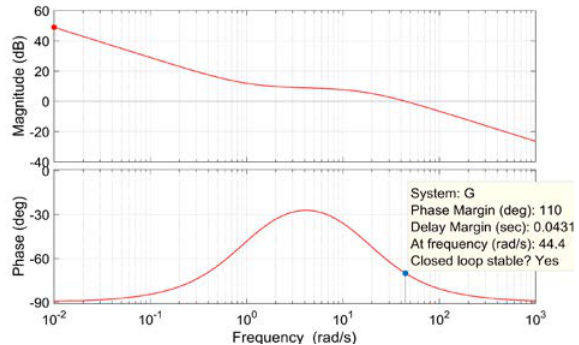
Fig . 5. Bode plot of plant and the controller open loop transfer function.